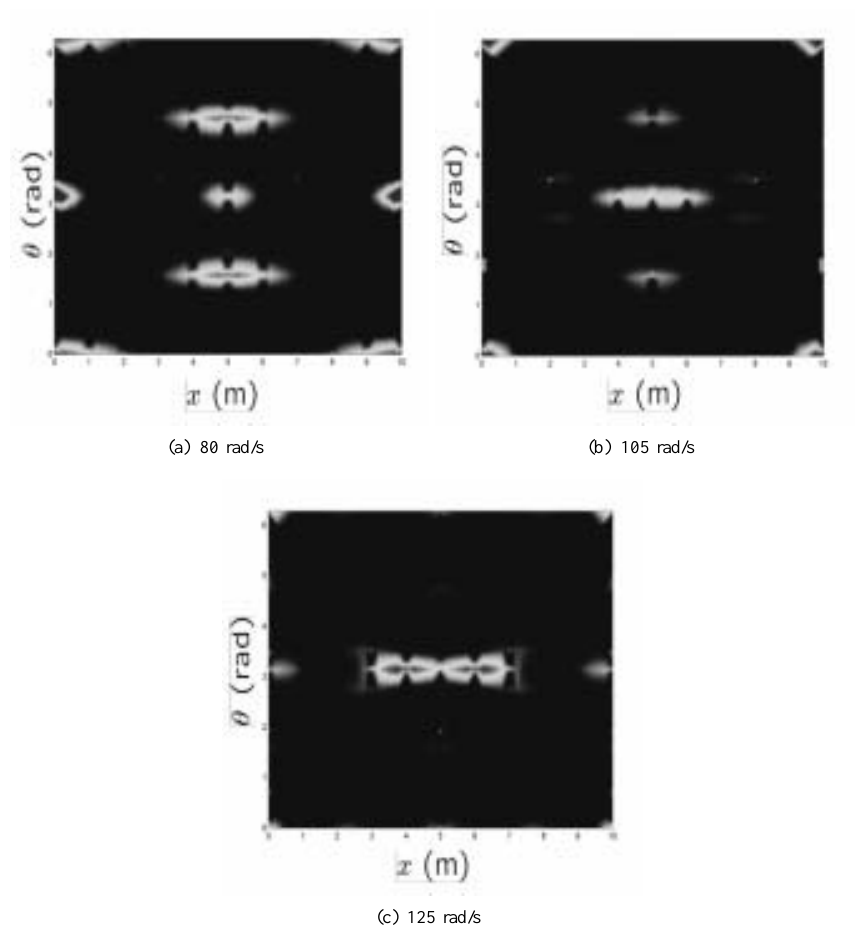
Fig. 10. Harmonic response of third rectangular grid ( a = 0 . 05 m, b = 0 . 05